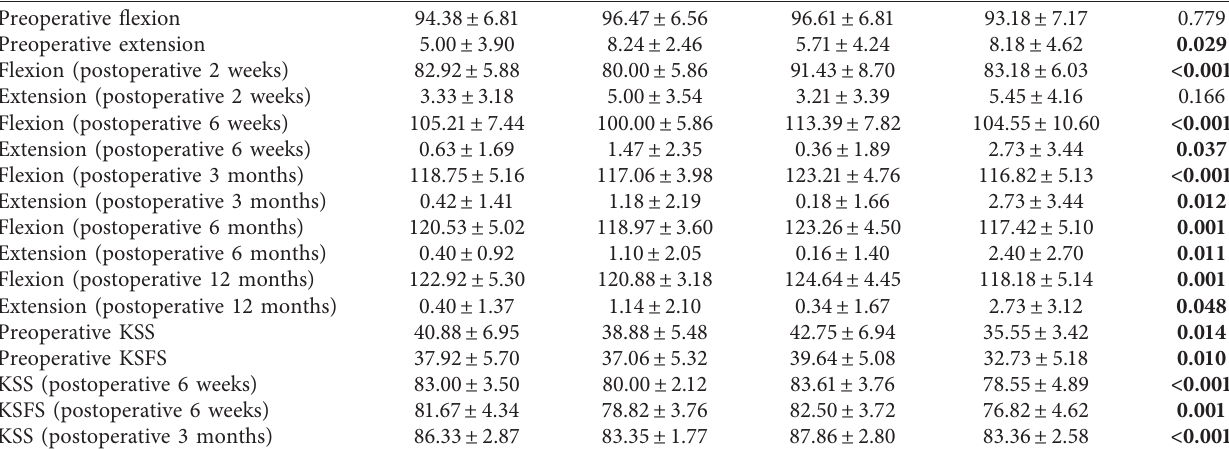
Table 4: Range of motion and functional scores before and after surgery.